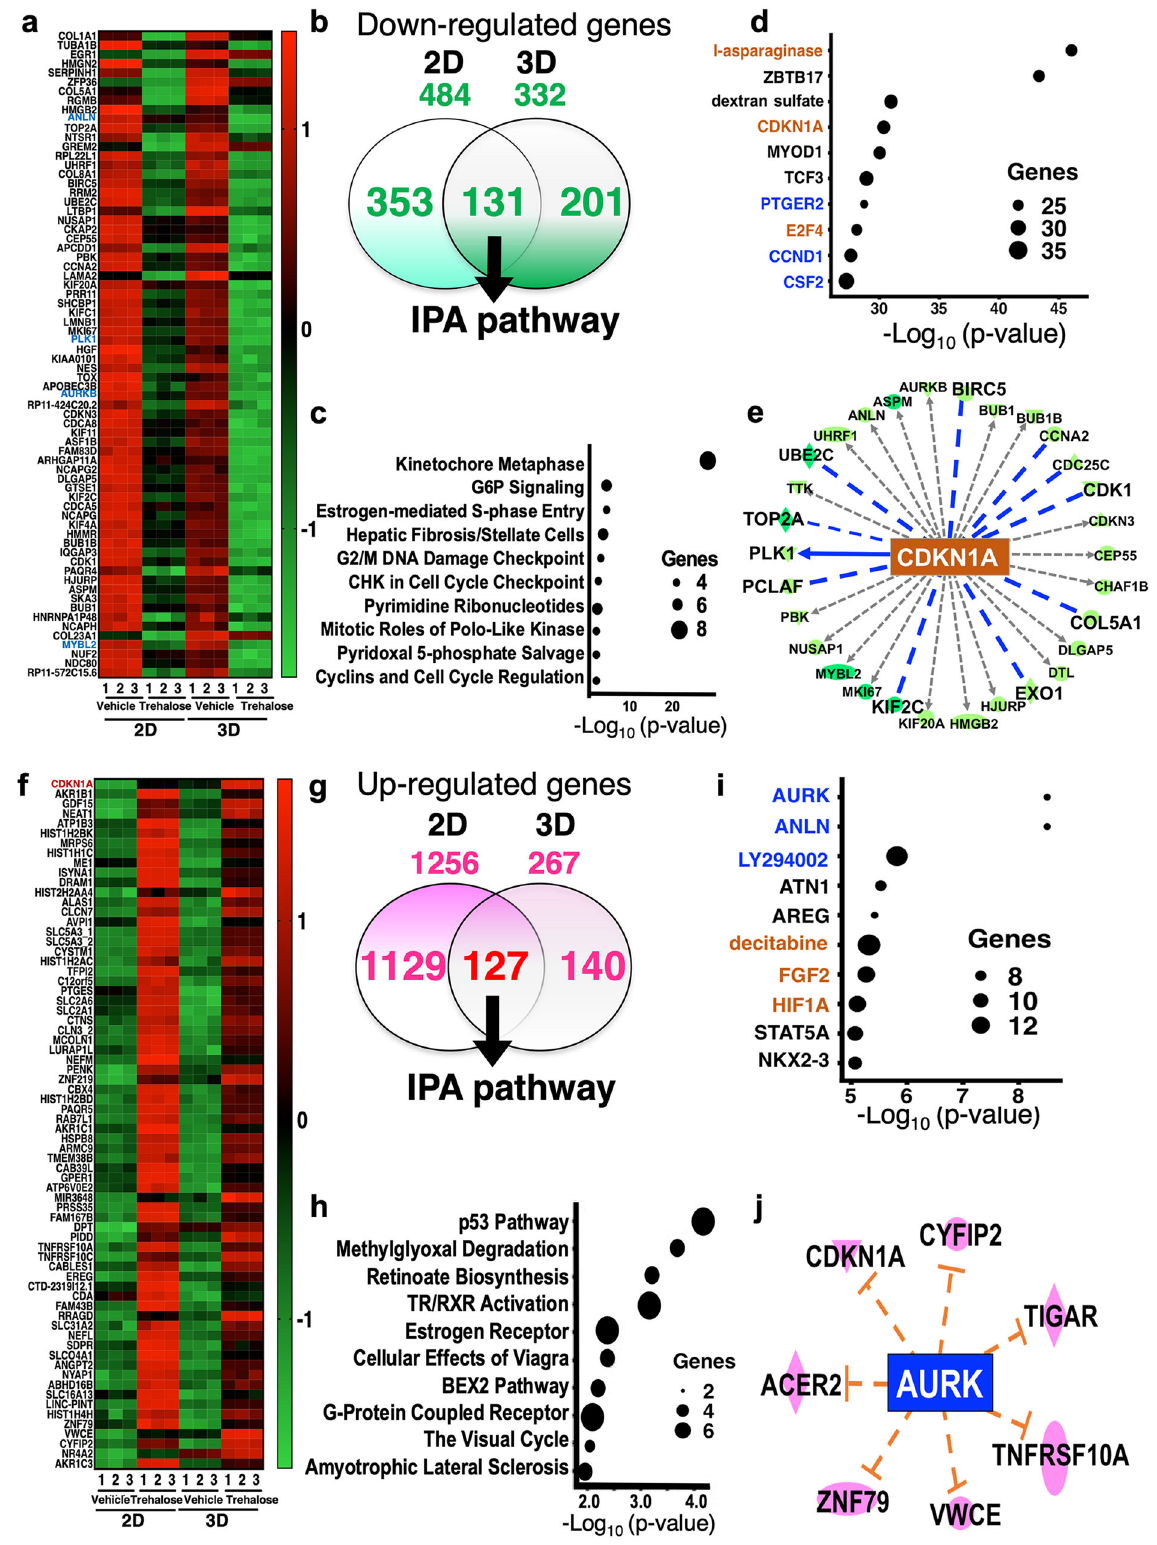
treatments induced similar DNA damage in fi broblasts, whereas hydrogen peroxide treatment induced remarkably more DNA damage than trehalose, evidenced by monitoring H2AX with phosphorylated Ser-139 ( γ H2AX) as a DNA damage marker (Fig. 5b). Similarly, fl ow cytometric analysis revealed that the per- centage of cells showing DNA damage differed nonsigni fi cantly